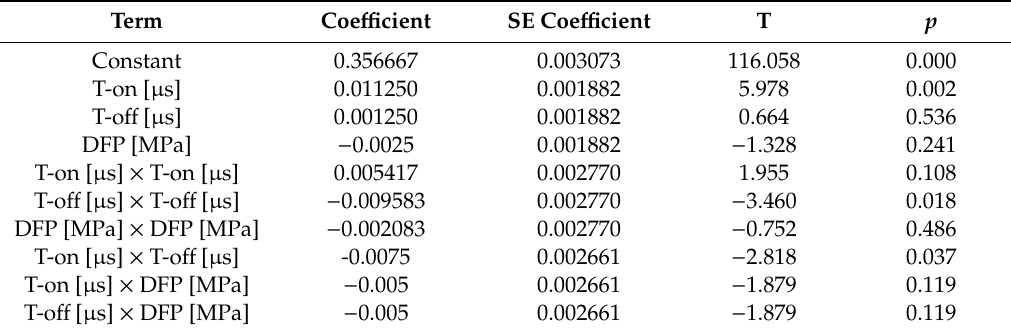
Table 7. Estimated coe ffi cients of the regression model and summary statistics of adopted response surface full quadratic model for